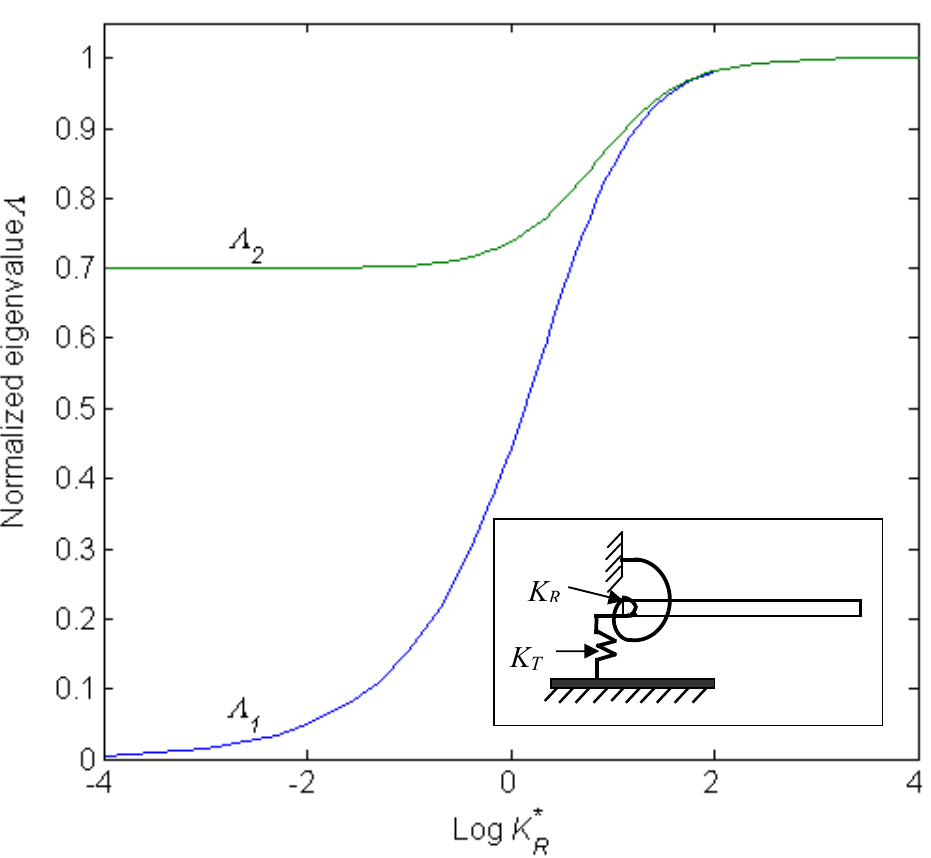
Figure 10. The variation of the first and second normalized eigenvalues of a boundary supported structure as a function of the rotational stiffness K R*